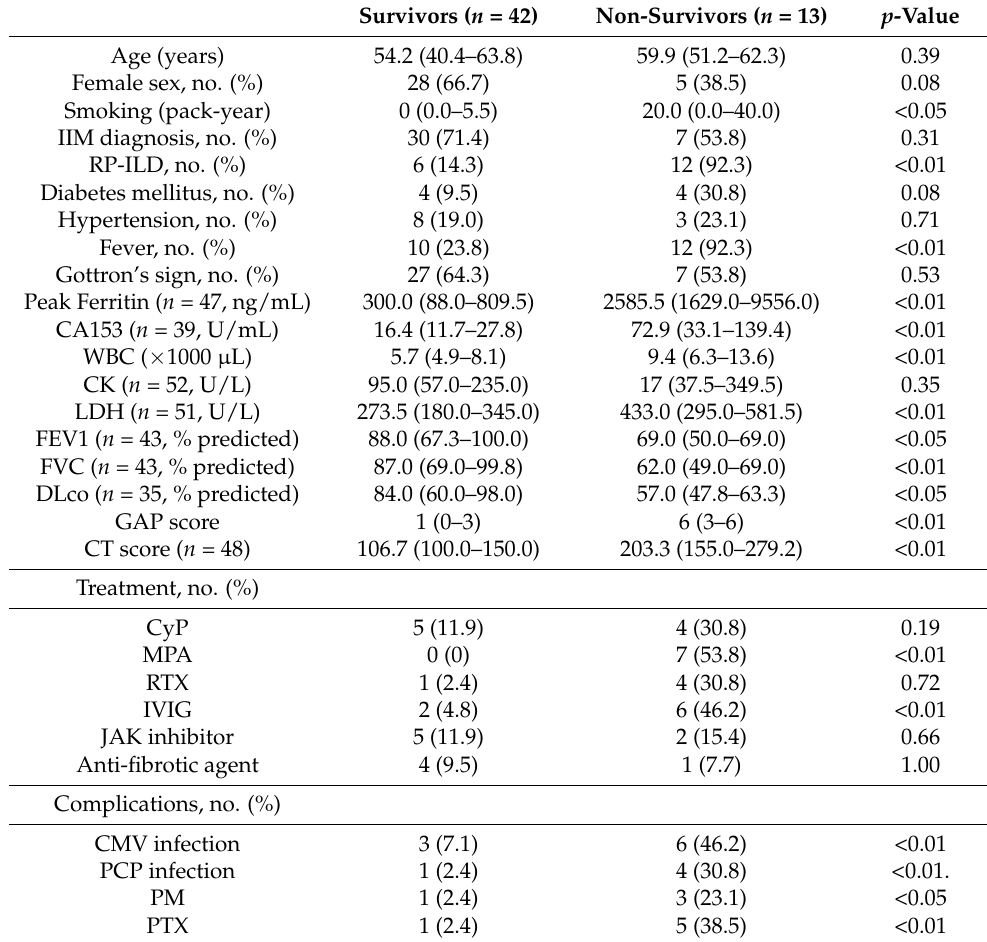
Table 1. Comparison between survivors and non-survivors at 1-year follow